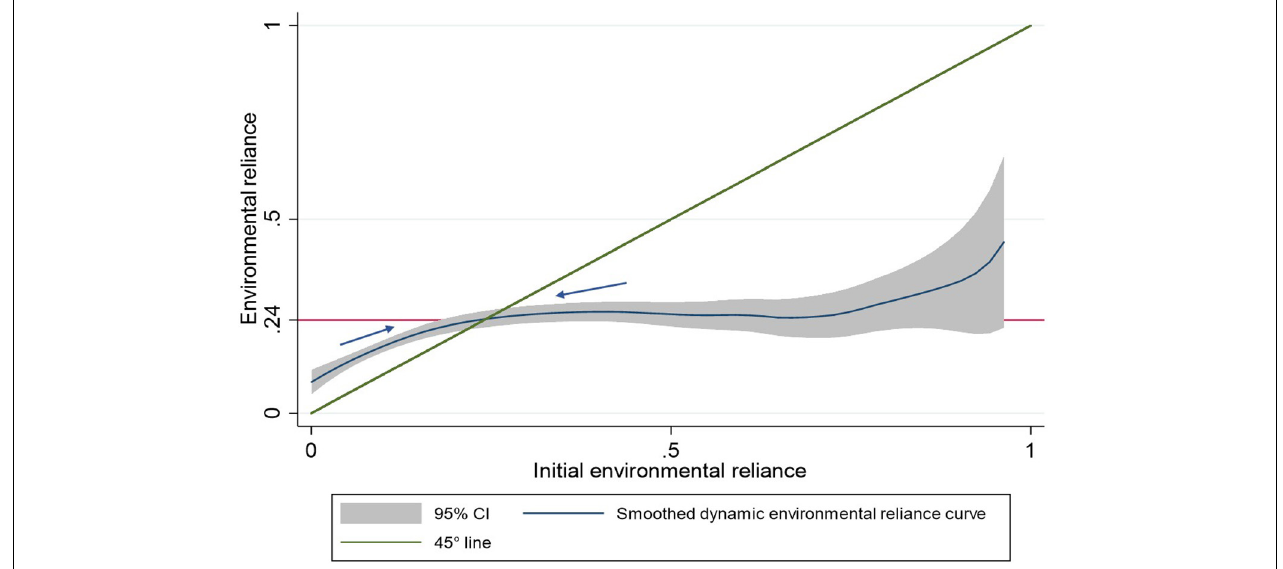
FIGURE 4 | The dynamics of rural household (pooled n = 1212) environmental reliance, based on non-parametric regression, in three districts of Nepal, 2006–2012 (the horizontal red line represents the equilibrium